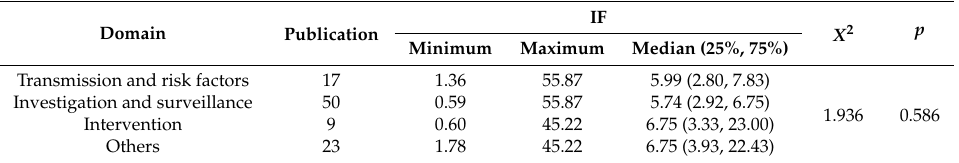
Table 8. IF across different domains in prevention and control study ( n = 99).